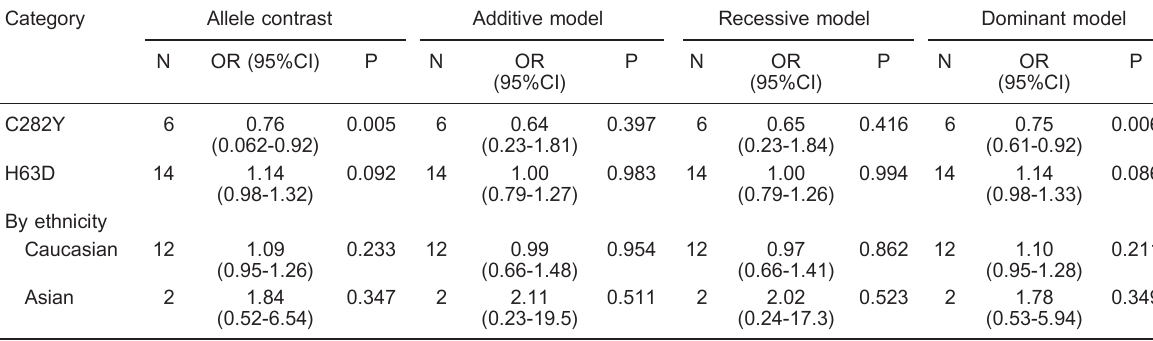
Table 3. Summary OR and 95%CI of the association between polymorphisms in the HFE genes (C282Y and H63D) and ALS